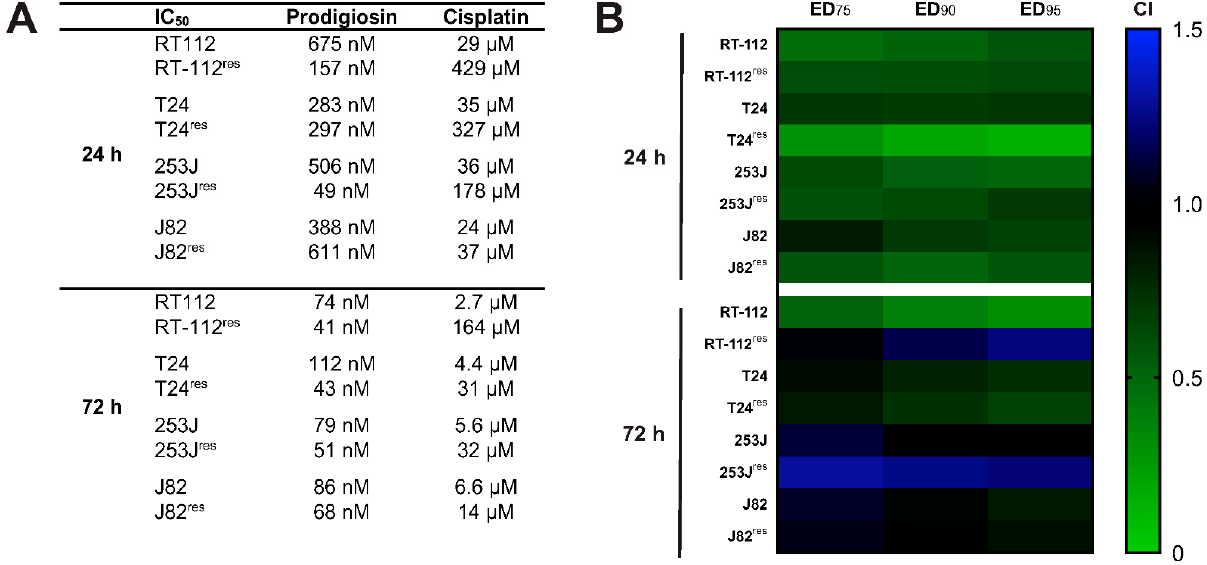
Figure 8. Prodigiosin increases cisplatin-mediated cytotoxicity in sensitive and -resistant bladder carcinoma cells. RT-112, RT-112 res , T24, T24 res , 253J, 253J res , J82 and J82 res cells were treated with different concentrations of prodigiosin and cisplatin alone or in combination for 24 or 72 h. After treatment, cell viability was measured using an MTT assay. ( A ) IC 50 values were calculated using GraphPadPrism using the results of three independent experiments performed in triplicates for each treatment. ( B ) For combinatory analysis, cells were treated with multiples of the IC 50 concentrations of prodigiosin and cisplatin alone or in combination. CI values were calculated for different effective doses (ED) using the software CompuSyn. CompSyn uses algorithms to extrapolate CI values for any effect level from the CI values of actual experiment points. Synergism (CI < 1; green), additivism (CI = 1; black) and antagonism (CI > 1; blue) can thereby be determined.